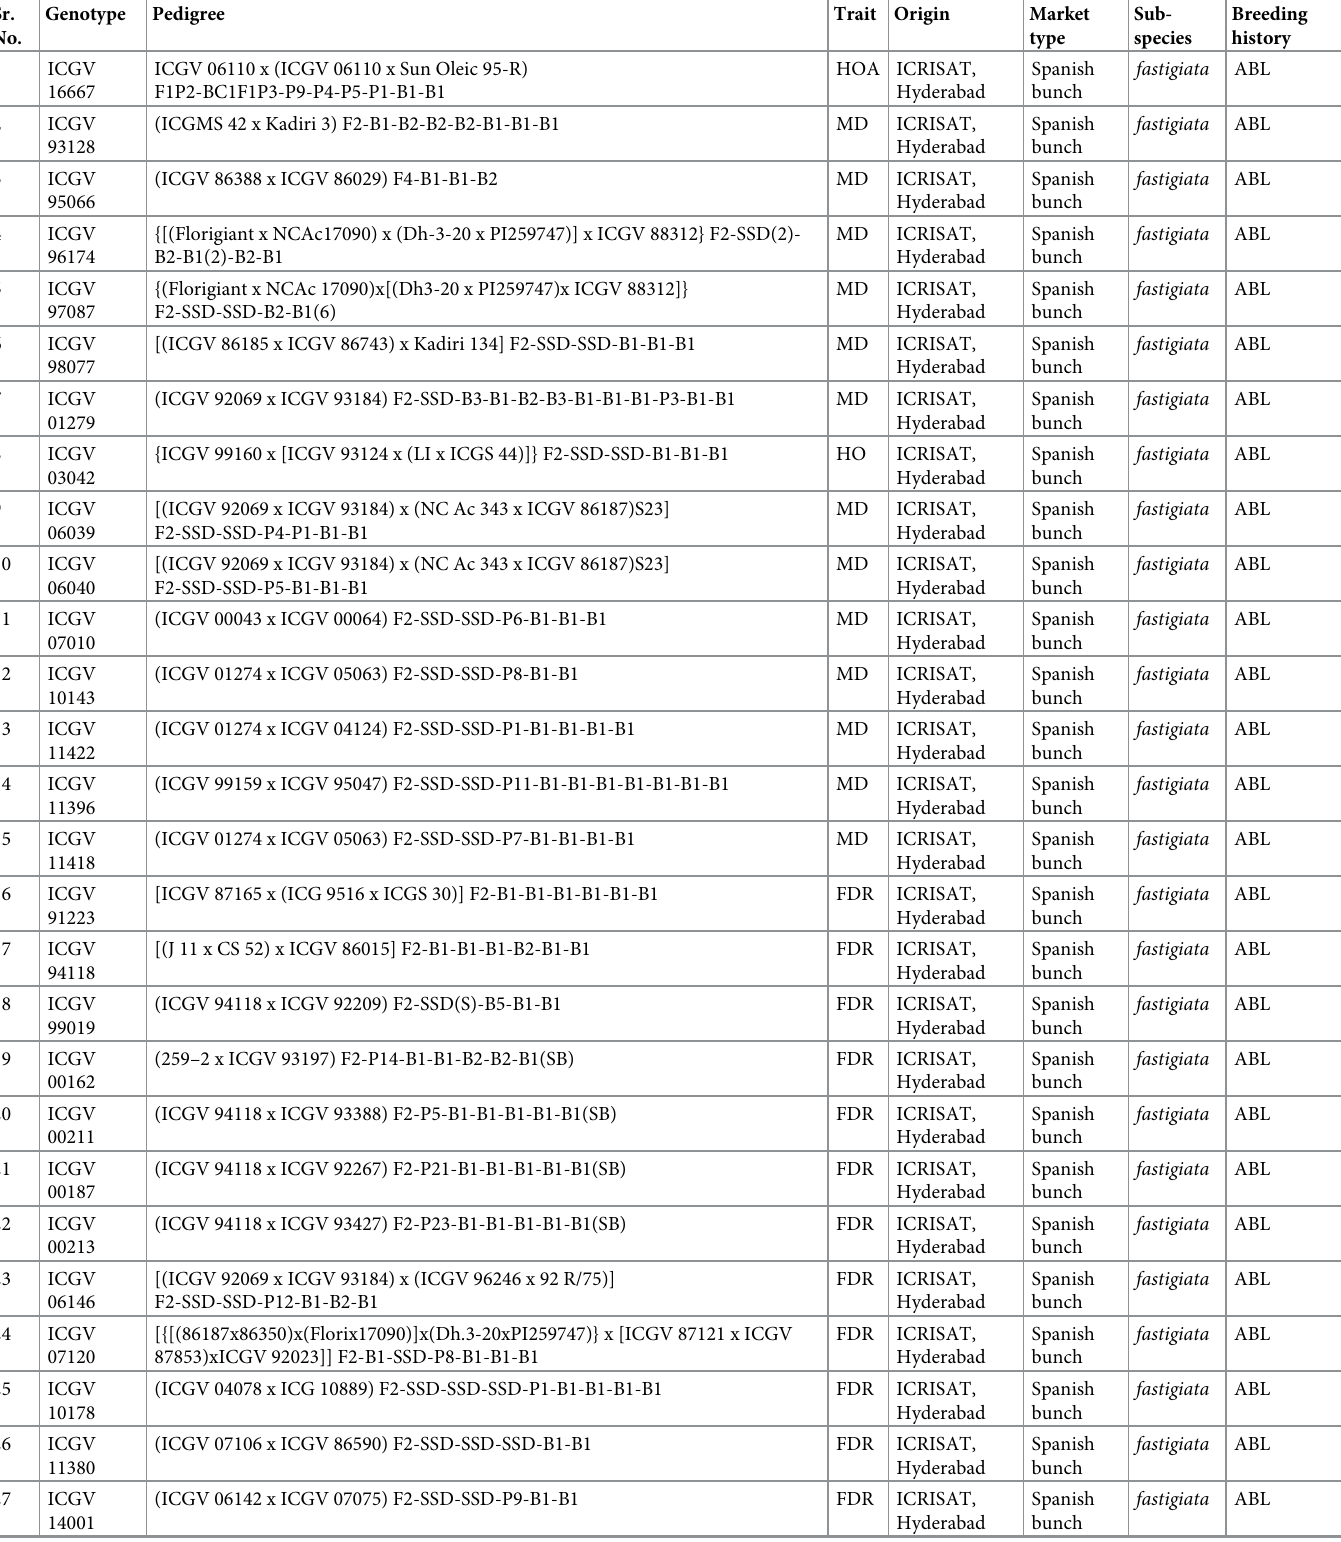
Table 1. Descriptions of the groundnut genotypes used for genetic diversity analysis. Sr. No.